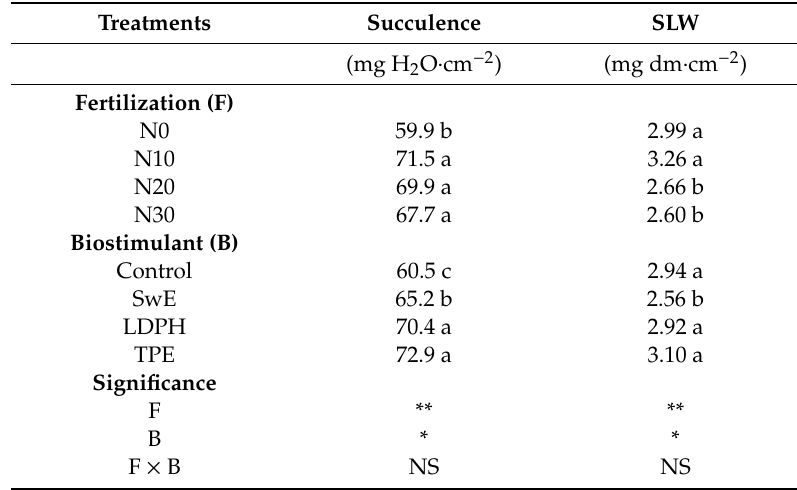
Table 2. E ff ects of nitrogen (N) fertilization levels (0, 10, 20 and 30 kg N · ha − 1 ; N0, N10, N20 and N30, respectively) and biostimulant applications (untreated control, SwE: Extract of seaweed Ecklonia maxima , LDPH: Legume-derived protein hydrolysate and TPE: Tropical plant extract) on leaf succulence and specific leaf weight (SLW) of baby lettuce